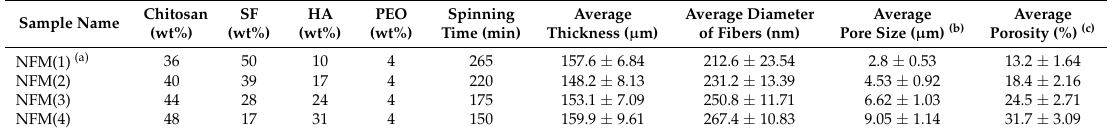
Table 1. Parameters of nanofibrious